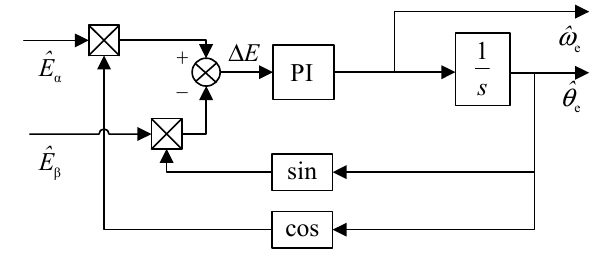
Figure 1. Block diagram of PLL.